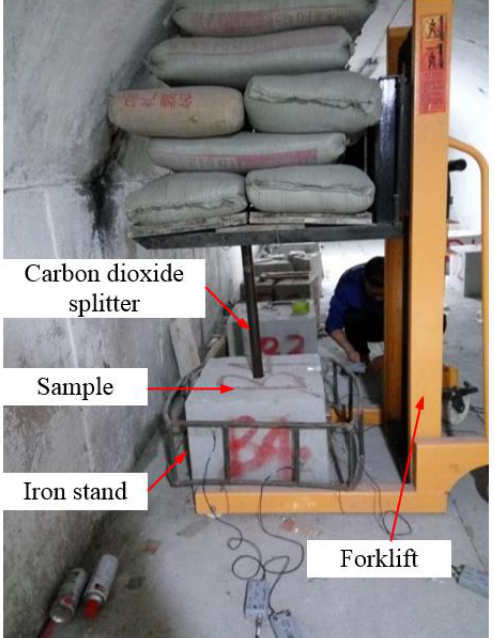
Figure 6. Fixed carbon dioxide splitter.